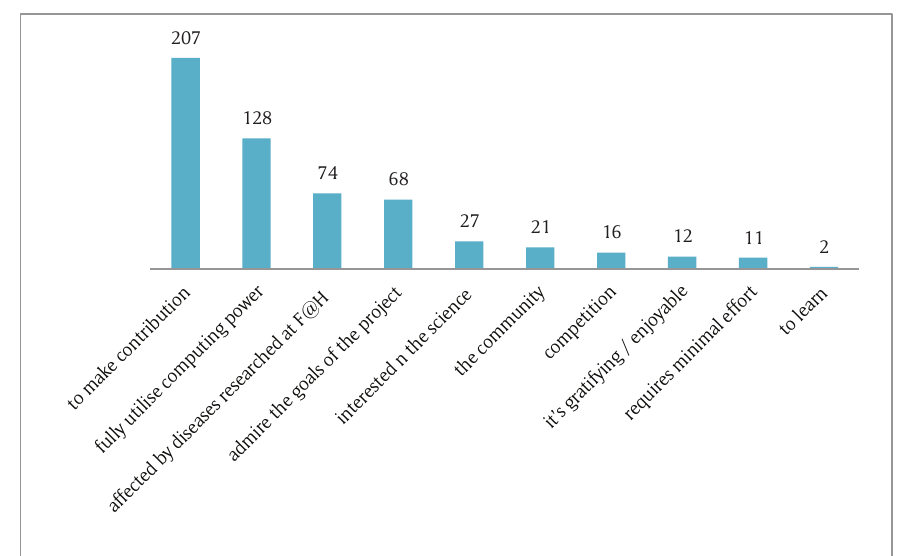
Figure 4: Motivations for participating in Folding@home.